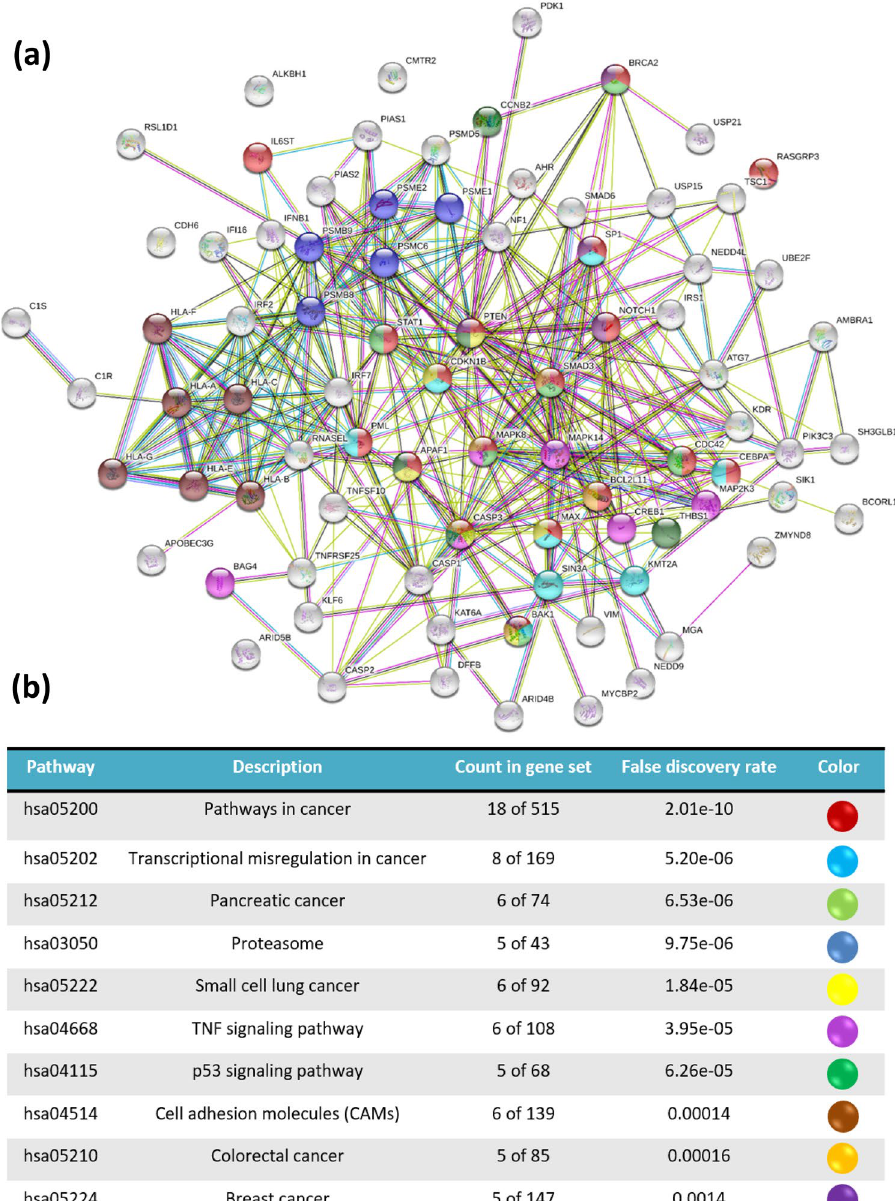
Figure 3. The STRING PPI network based on the KEGG pathways 21–23 . ( a ) The protein–protein interaction of both up/down-regulated DEGs showed a meaningful co-expression. Highlighting nodes by oncogenic signalling pathways illustrated the hub genes. ( b ) The selected oncogenic signalling